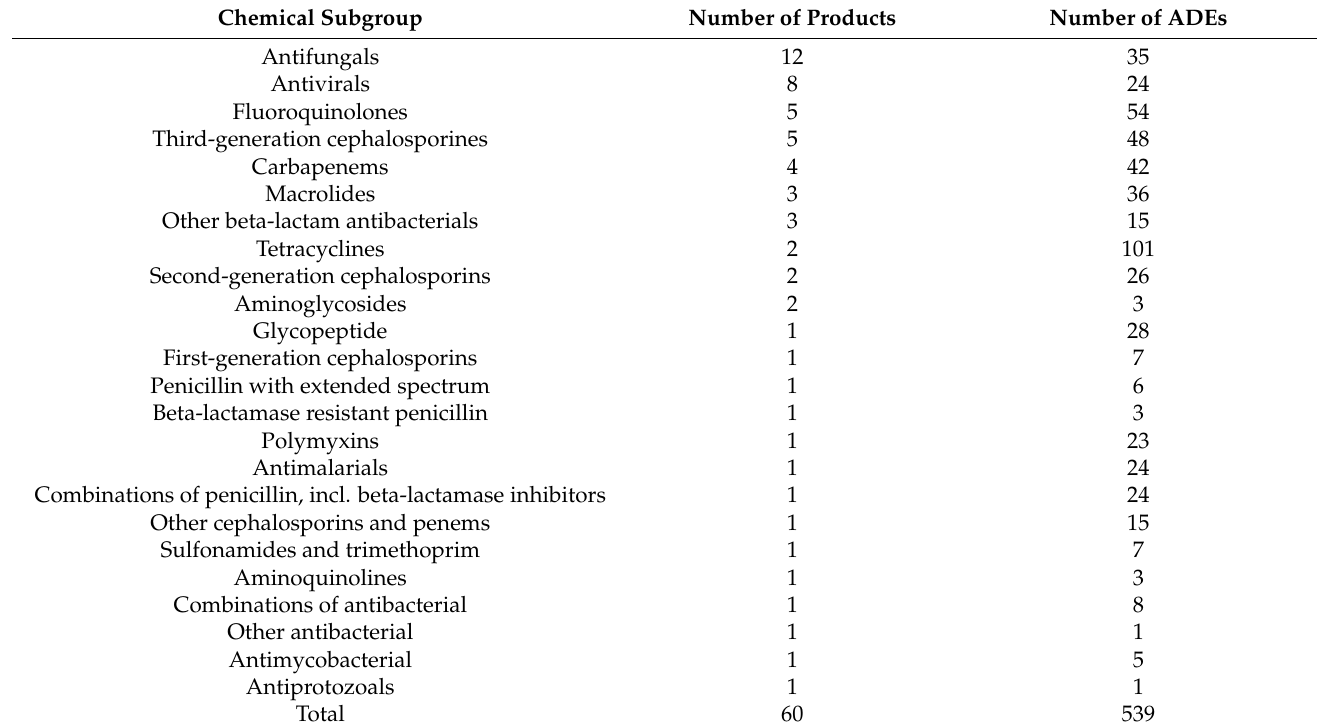
Table 2. Chemical subgroups of drugs and their ADRs included in the